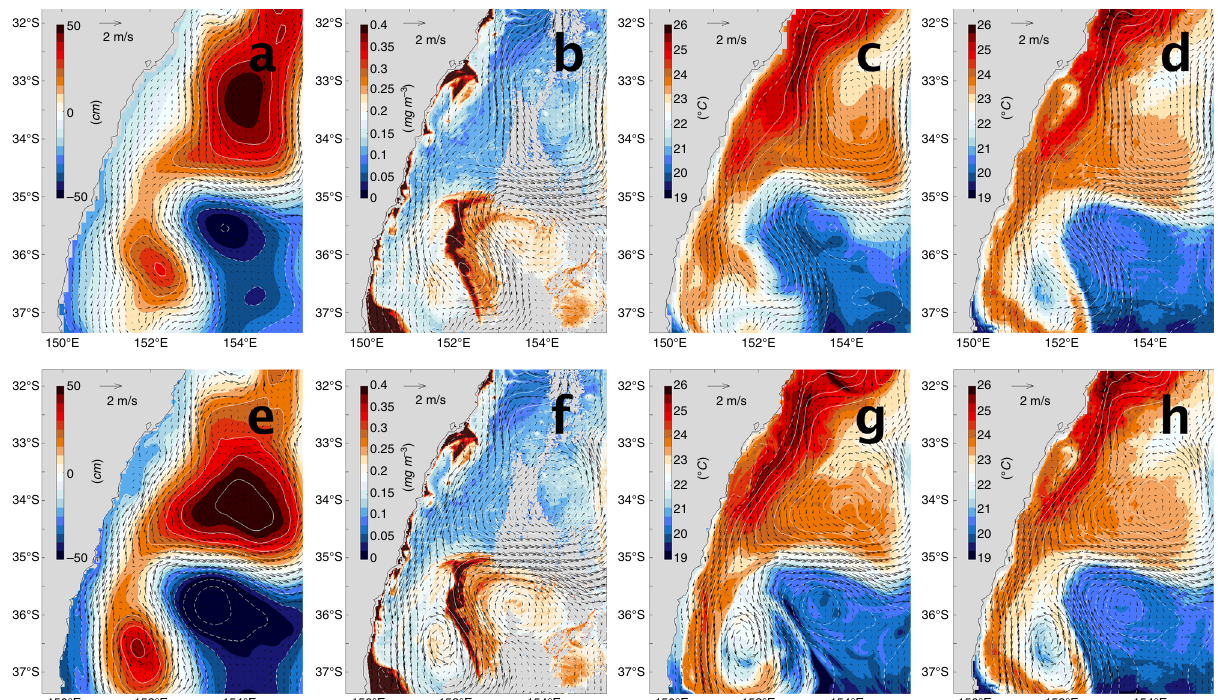
Fig. 2 Analysis of mesoscale oceanographic circulation in the East Australian Current separation region on the 11th April 2006. a SLA † and SC † , ( b ) MODIS chlorophyll- α with SLA † and SC † , ( c ) SST † , ( d ) AHVRR SST with SLA † and SC † , ( e ) SLA ‡ and SC ‡ , ( f ) MODIS chlorophyll- α with SLA ‡ and SC ‡ , ( g ) SST ‡ and ( h ) AHVRR SST with SLA ‡ and SC ‡ . Sea level anomaly (SLA), Sea surface temperature (SST), Surface Current (SC), Advanced very-high resolution radiometer (AVHRR) and Moderate Resolution Imaging Spectroradiometer (MODIS). SLA contour interval is 10 cm. The thickened white contour represents zero SLA and dashed contours correspond to negative values. † 10 km horizontal resolution system and ‡ 2.5 km horizontal resolution system